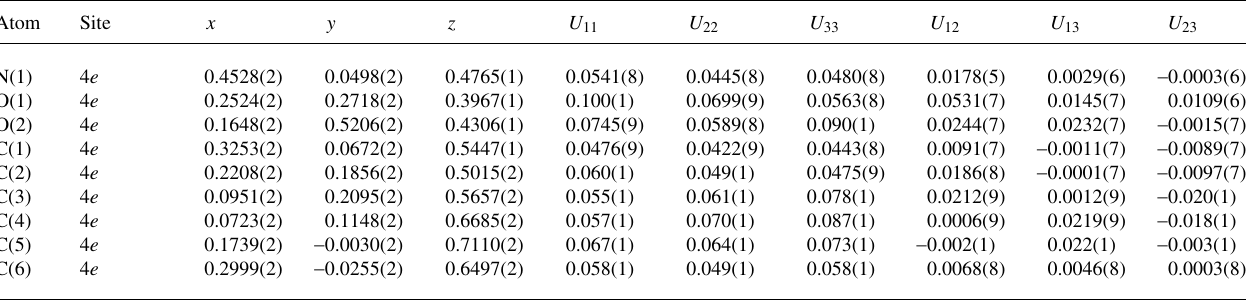
Table 3. Atomic coordinates and displacement parameters (in Å 2 )